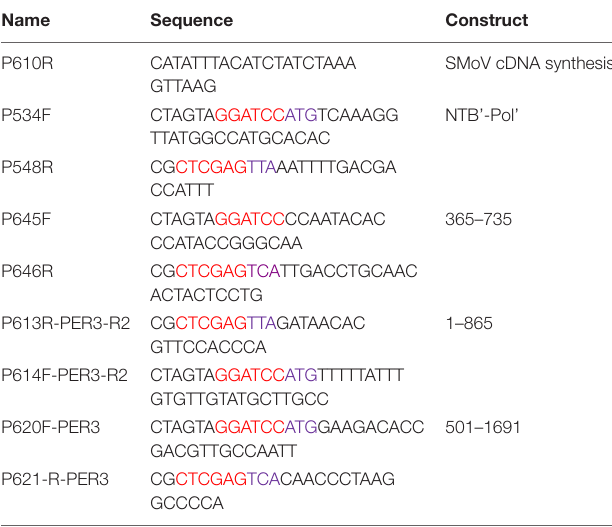
TABLE 1 | List of primers used in this study. TABLE 2 | Alignment of potential cleavage sites for members of the family